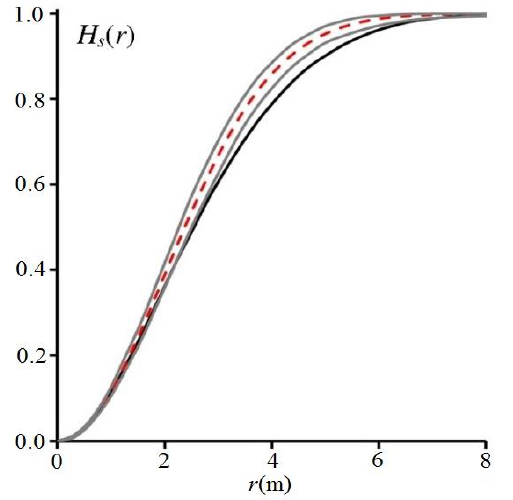
Figure 8. The results of inhomogeneous spherical contact distribution function H s ( r ) in spatial pattern analysis of eshnan Figure 6. The inhomogeneous O -ring statistic displayed shrubs in the study significant aggregation of eshnan shrubs at scales of 1-3 m (λ = 0.039).